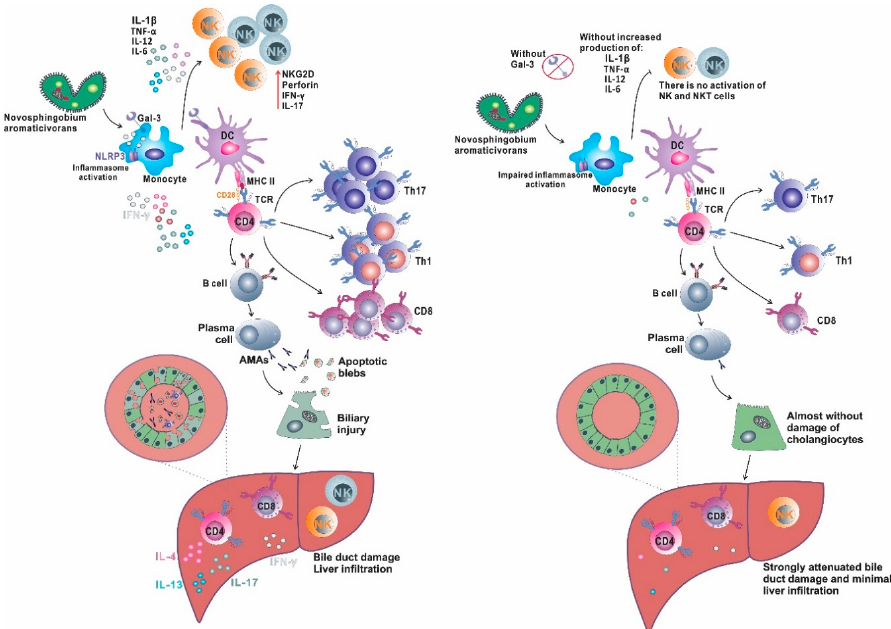
Figure 1. Gal-3 in inflammasome activation and PBC development. Novosphingobium aromaticivorans infection activates innate immune cells (monocytes / macrophages) and in the presence of Gal-3